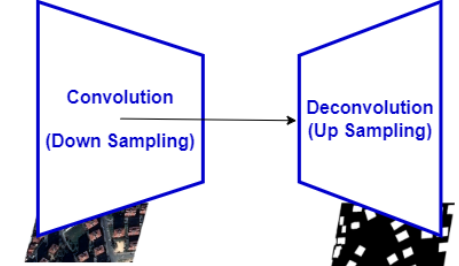
Figure 3 . Encoder-Decoder Network.